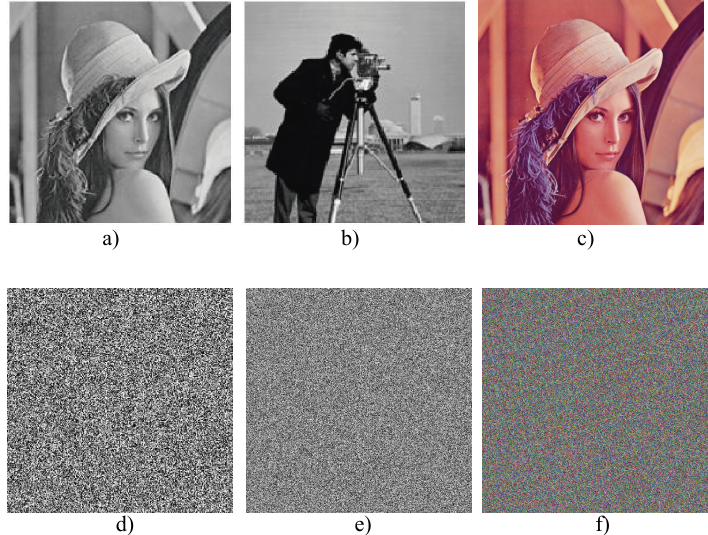
Figure 5. Images used to perform security analysis tests. ( a ) Lena image 255 × 255 gray scale pixels; ( b ) Cameraman Image 512 × 512 gray scale pixels; ( c ) Image of Lena RGB 512 × 512 pixels; ( d – f ), their respective cryptogram.